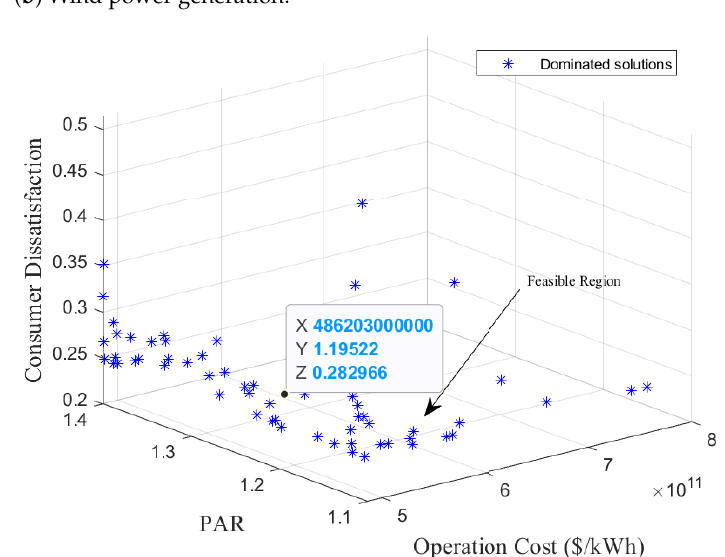
Figure 2. Forecast and actual power generation of PV and wind units [28]. ( a ) PV power generation. ( b ) Wind power generation.